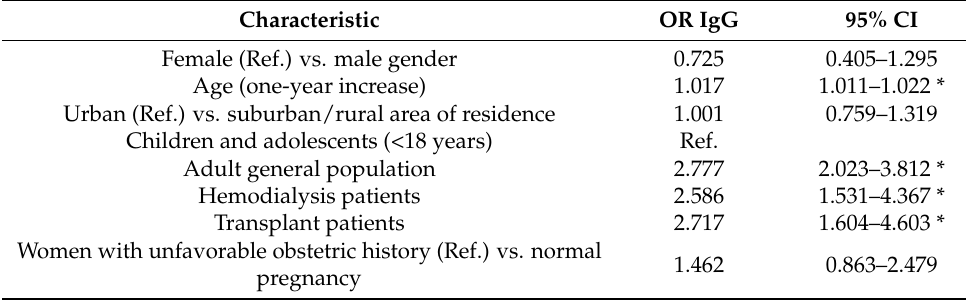
Table 3. Logistic regression risk analysis for the parvovirus B19 IgG seropositivity. Characteristic OR IgG 95% CI Female (Ref.) vs. male gender 0.725 0.405–1.295 Age (one-year increase) 1.017 1.011–1.022 * Urban (Ref.) vs. suburban/rural area of residence 1.001 0.759–1.319 Children and adolescents (<18 years) Ref. Adult general population Hemodialysis patients Transplant patients pregnancy